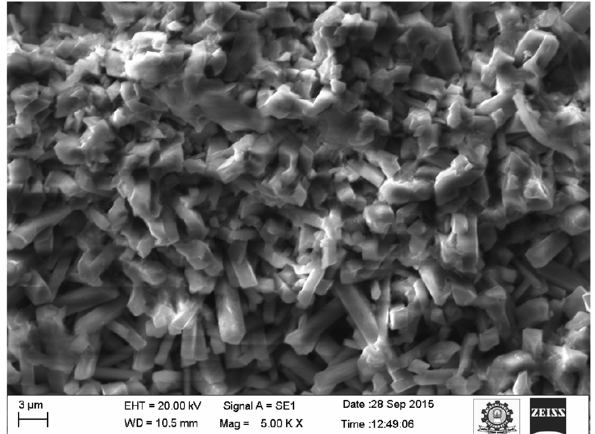
Figure 11: Surface morphology of the exposed sample after removal of